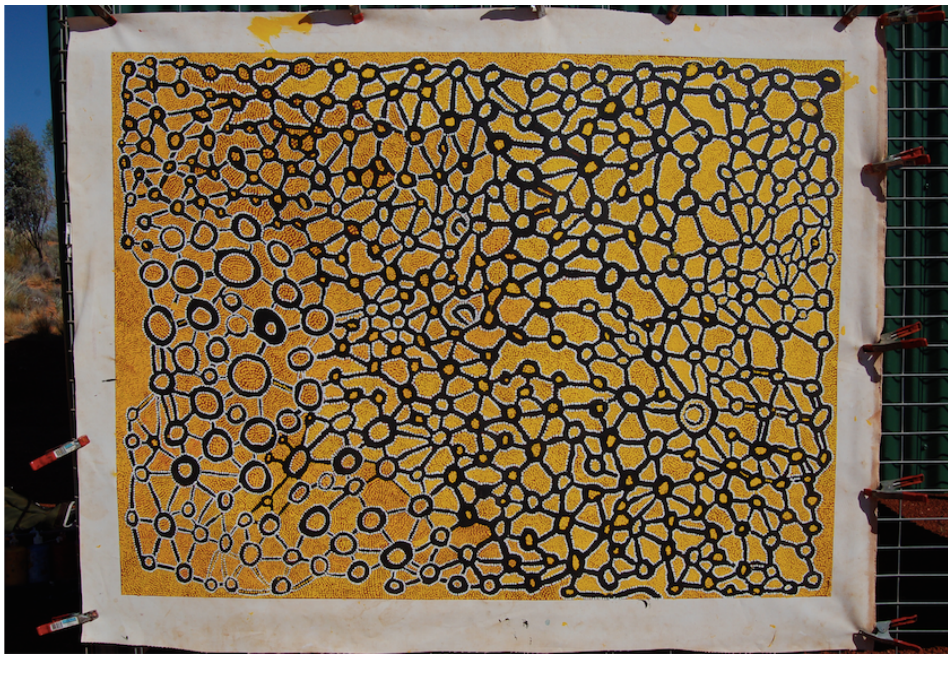
Fred Grant and Carlene West, Ukatjatjara , 2006. Acrylic on linen, 183 x 137 cm. Private collection (photo: courtesy Spinifex Arts